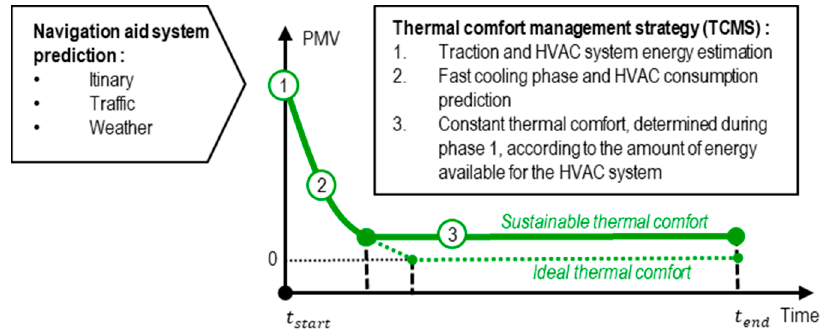
Figure 4. Schematic view of the proposed thermal comfort management strategy.